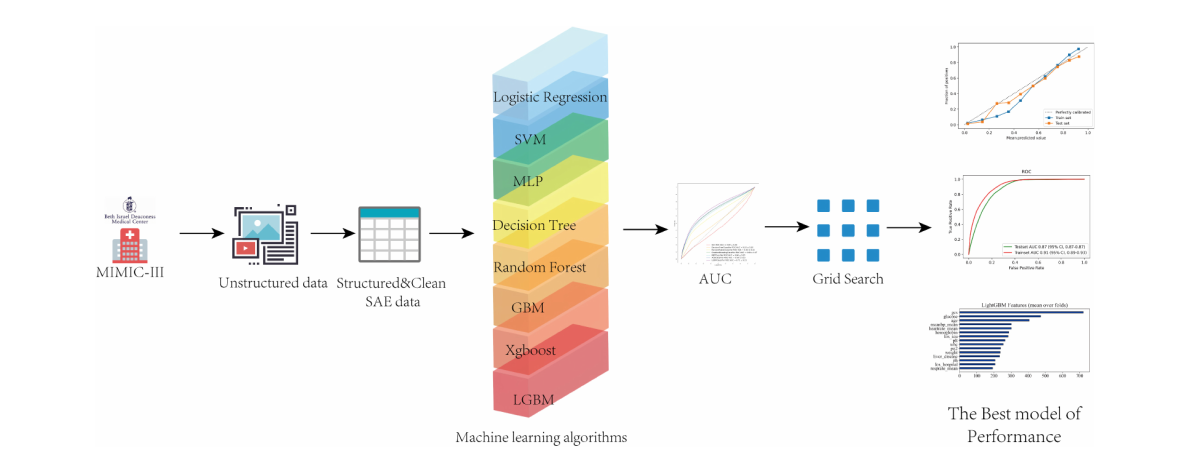
FIGURE1 A flow chart of the study. AUC, area under the curve, SVC, support vector classification; MLP, multi-layer perceptron; XGB, extreme gradient boosting; LGBM, light gradient boosting machine.